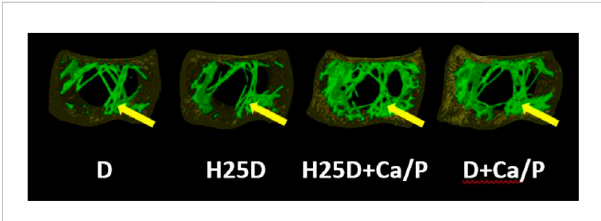
FIGURE 2 Total pattern factor, matrix, and thickness within the trabecular bone region. 1) Arrow indicating the pattern factor, matrix, and thickness within the trabecular region of the bone. 2) D = vitamin D3 (2,760 IU/kg); H25D = vitamin D3 (2,760 IU/kg) + 62.5 mg HyD/ ton (full dose); H25D + Ca/P = vitamin D3 (2,760 IU/kg) + 62.5 mg